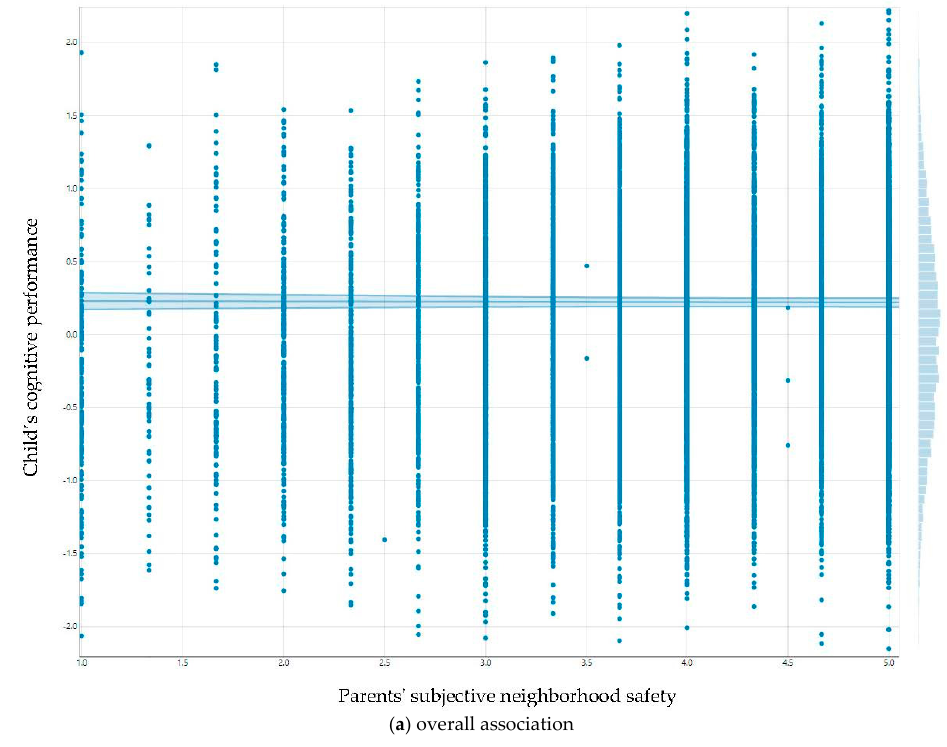
Table 4. Summary of mixed-effects regressions on the association between parent’s neighborhood safety and children’s cognitive performance (executive functioning) overall and by race/ethnicity.